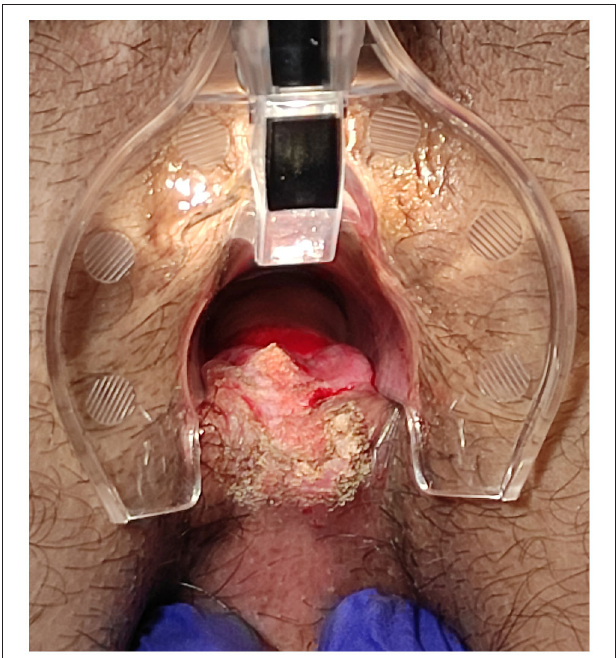
FIGURE 4 | Posterior fissure: sentinel skin tag CO 2 laser scanner vaporisation and fissure superficial vaporisation and debridement.